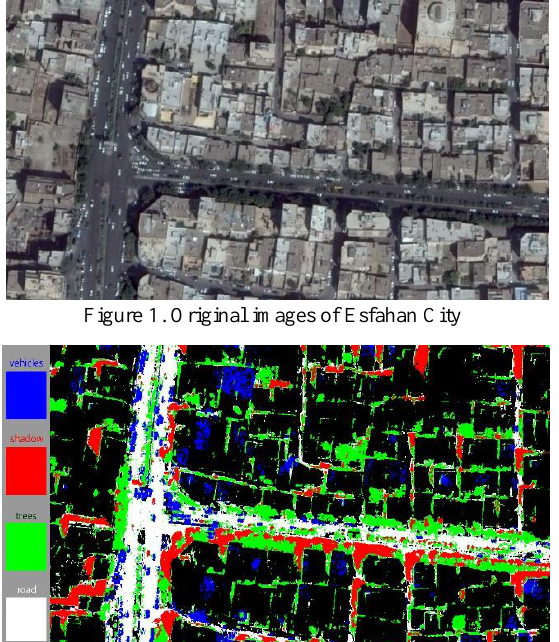
Figure 2. Classified image by maximum likelihood